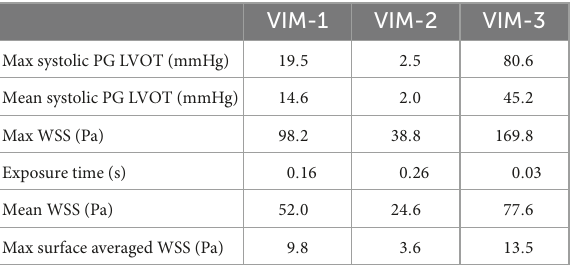
TABLE 4 Pressure gradients and wall shear stress